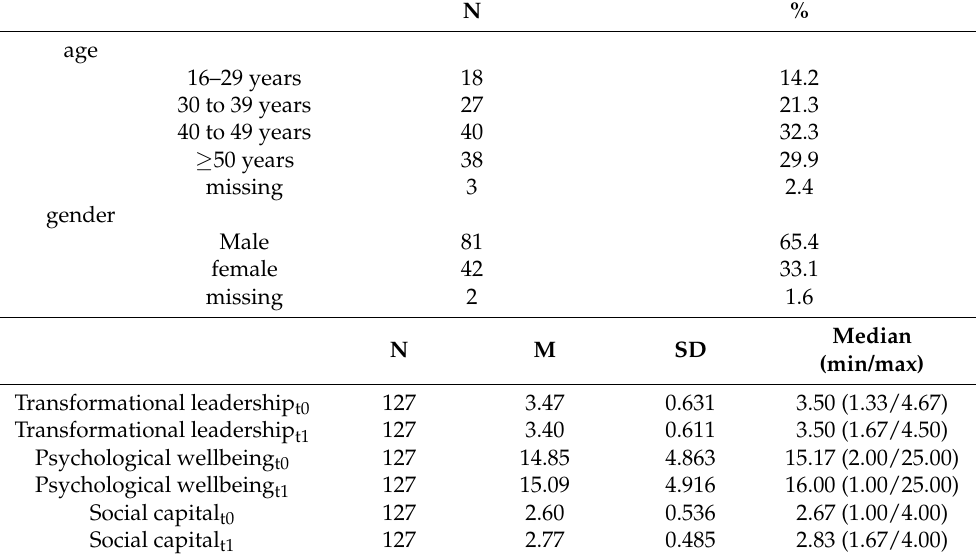
Table 1. Descriptions of study